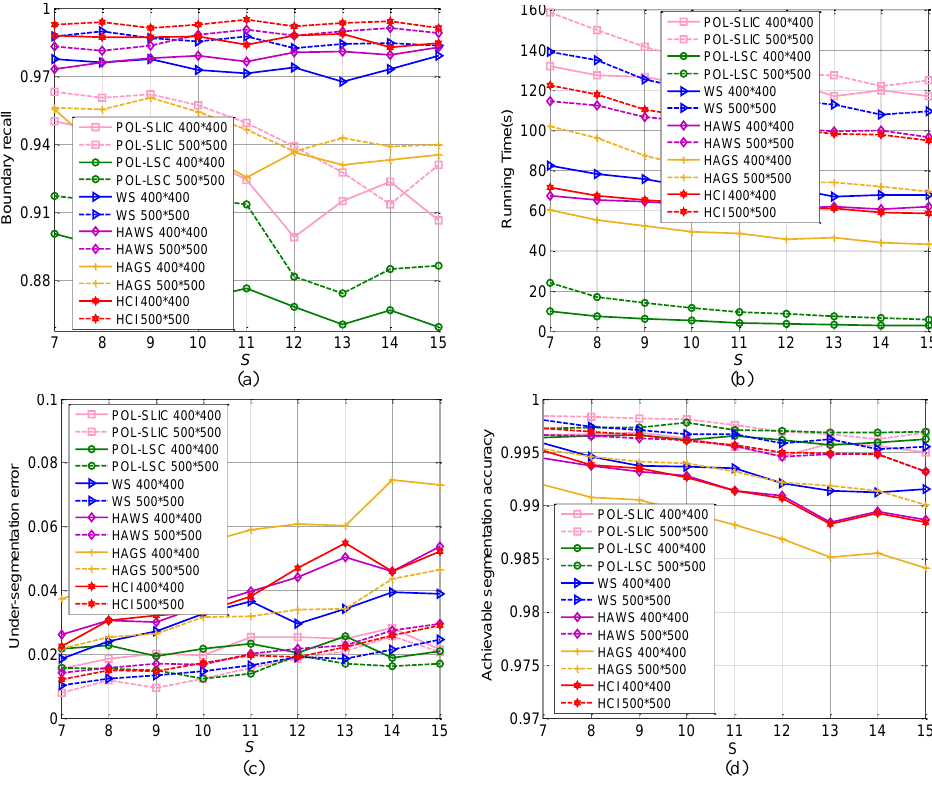
Figure 11. Quantitative evaluation results of two simulated data sets. ( a ) BR. ( b ) RT(s). ( c ) USE. ( d )